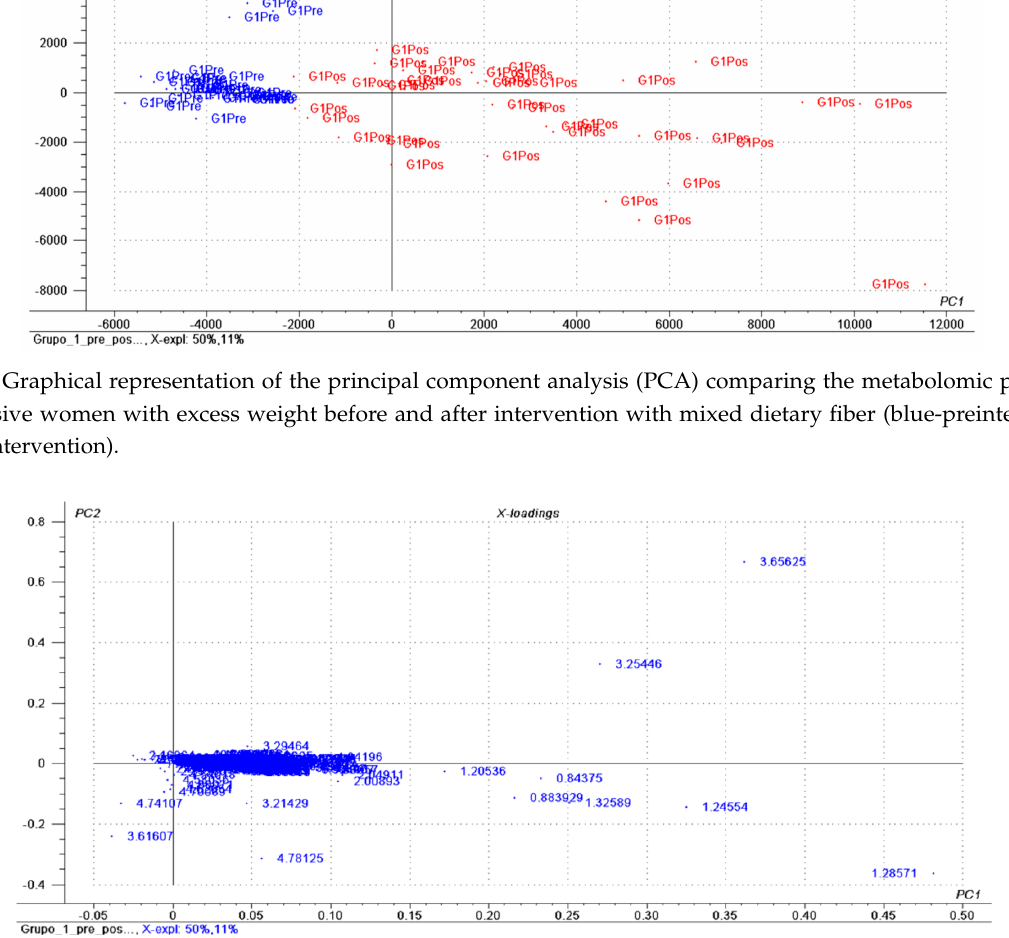
Figure 2. Metabolites identified and highlighted based on the principal component analysis (PCA), presented as a loading graph, comparing the metabolic profiles of hypertensive women with excess weight before and after intervention with mixed dietary fiber.